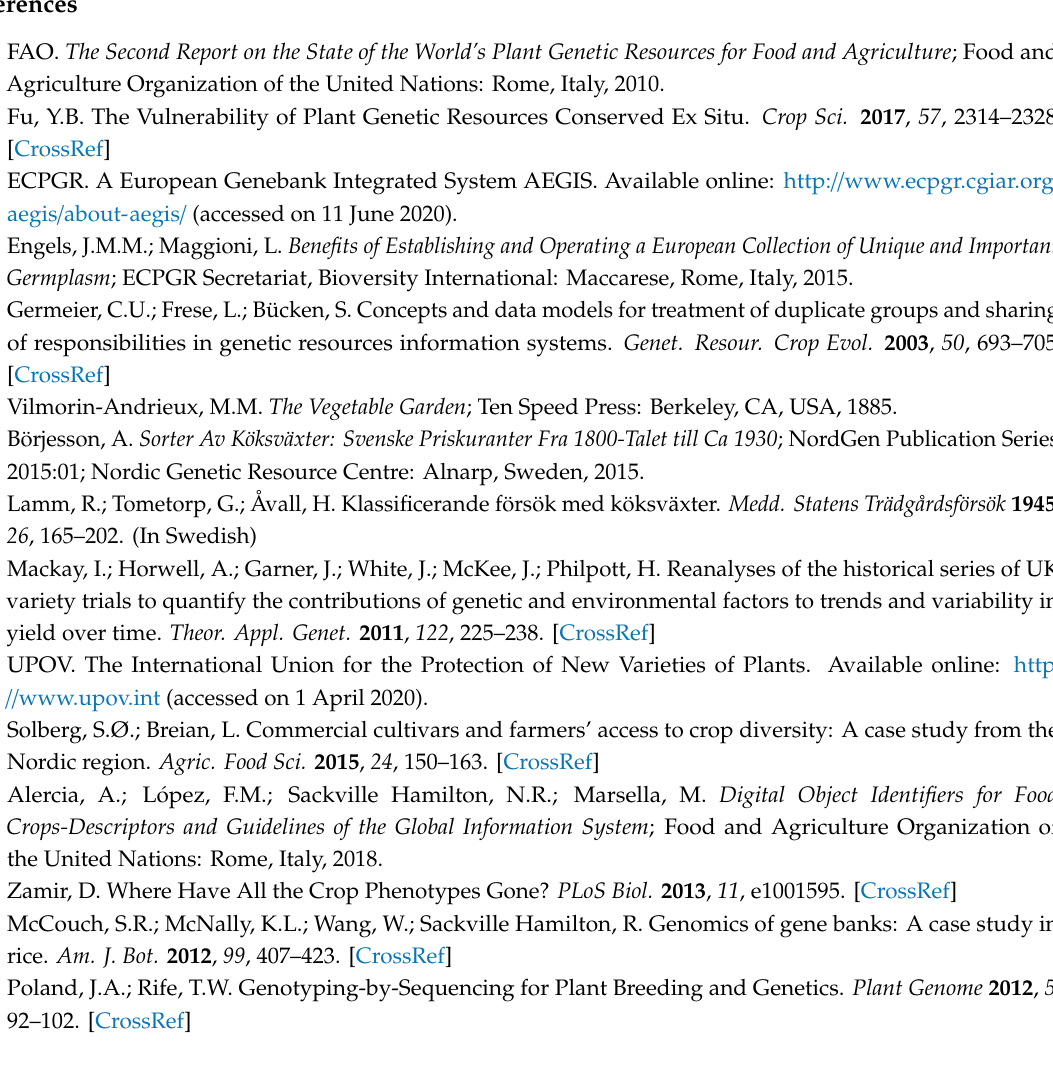
Figure S2: Results of the individual level principal component analysis (PCA) based on SNP markers. Figure S3: F ST values between di ff erent accessions based on 1000 subsamples of each 10, 50, 100 and 500 SNP markers respectively. Figure S4: Results from PCA when subsampling 20 SNP markers: A) individual level analysis and B) accession-level analysis. Figure S5: Subsampling of SNP markers for STUCTURE analysis assuming two genetic clusters (K = 2). Figure S6: Comparison of STRUCTURE analyses of 10 subsets of 50 randomly chosen SNP markers. Table S1: Morphological descriptors with means and standard deviations. Table S2: Pairwise F ST values among all investigated accessions. Table S3: Average number of pairwise shared SNP alleles among all investigated accessions. Table S4: Marker subset suggested for the identification of duplicate accessions (Excel